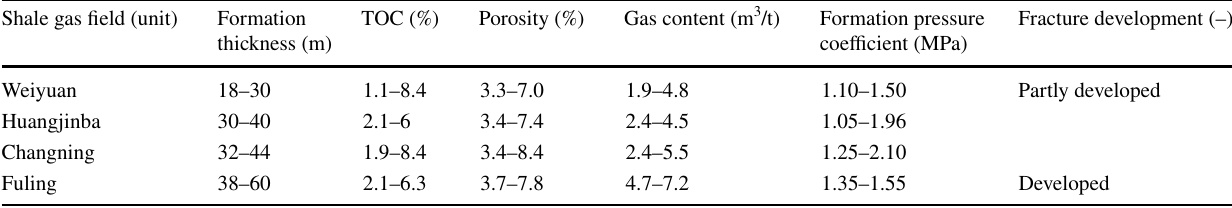
Fig. 2 Workflow of the methodology to quantify the uncertainty in production Table 1 Range of some parameters from shale gas fields in Southwestern China Shale gas field (unit)